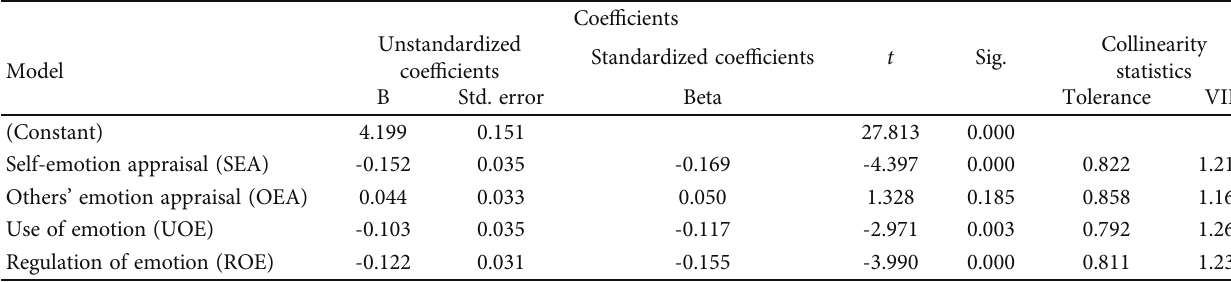
Table 5: Regression analysis result.